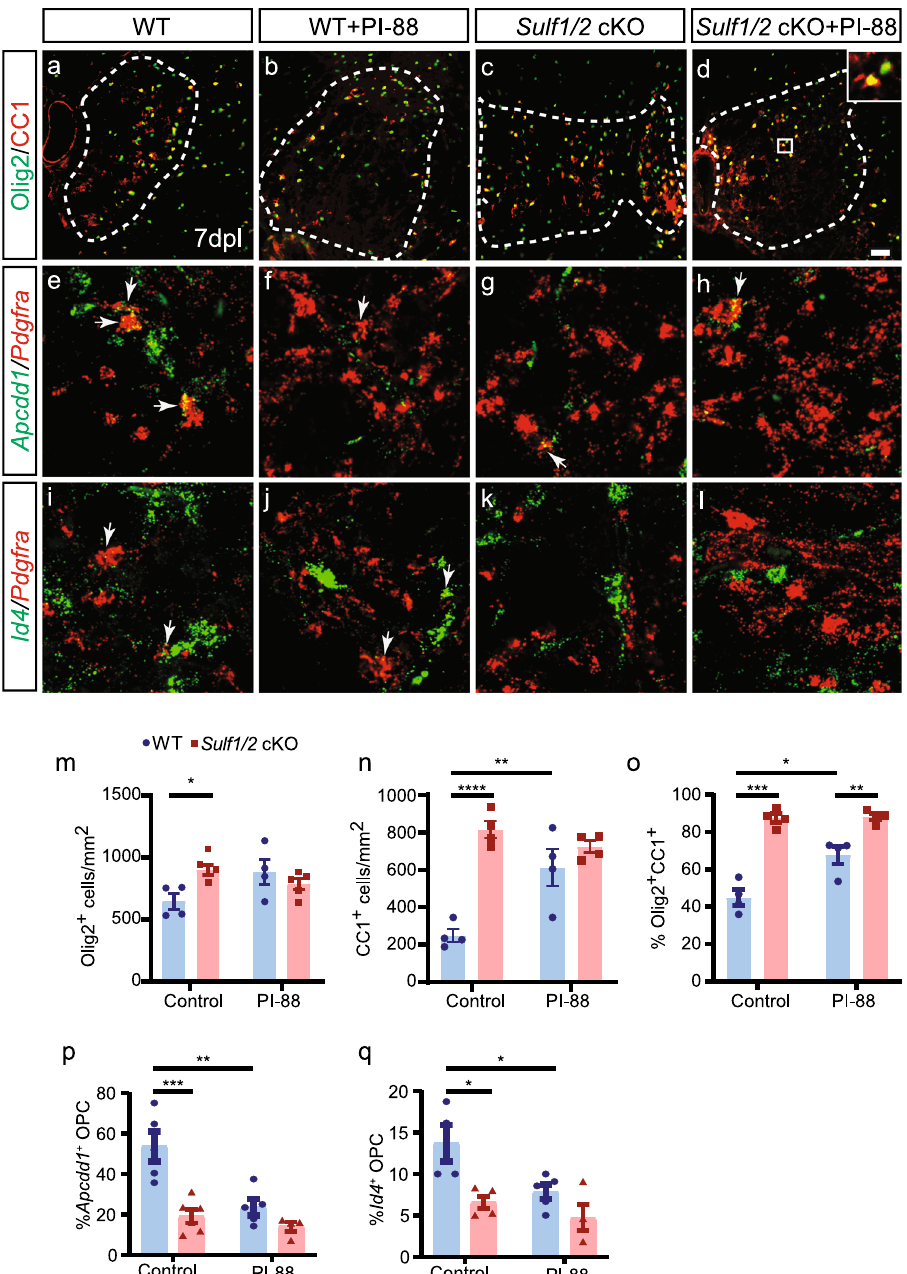
Fig. 8 PI-88 treatment accelerated OL differentiation via inhibition of Sulf1/2 following demyelination. Wild-type (WT) and Sulf1/2 cKO mice underwent focal spinal cord demyelination with or without PI-88 injection and were sacri fi ced at 7 days post lesion. a – d Olig2 (green)/CC1 (red) immuno fl uorescence. e – l Confocal RNAscope in situ hybridization for OPC-expressed Pdgfra (red) and either WNT target gene Apcdd1 (green, e – h ) or BMP target gene Id4 (green, i – l ). Arrows indicate double-labeled OPCs. m – o Quanti fi cation of oligodendrocyte lineage density (Olig2 + , m ) ( n = 4 mice for WT, n = 5 mice for Sulf1/2 cKO groups), postmitotic CC1 + Olig2 + cells ( n ) ( n = 4 mice per group), and percentage of CC1 + cells within the Olig2 population ( o ) ( n = 4 mice per group). Quanti fi cation of WNT pathway activity Appcd1 % ( p ) ( n = 5 mice for control WT and PI-88 treated WT, n = 6 for control Sulf1/2 cKO, and n = 4 for PI-88 treated Sulf1/2 cKO) and BMP pathway activity Id4 % ( q ) ( n = 4 mice for control WT and PI-88 treated Sulf1/2 cKO groups and n = 5 for PI-88 treated WT and control Sulf1/2 cKO groups) among Pdgfra + OPCs. Mean ± SEM is shown. *, **, ***, and **** indicate two-way ANOVA Holm – Sidak post-test p < 0.05, <0.01, <0.001, and <0.0001, respectively. Scale: 20 µ